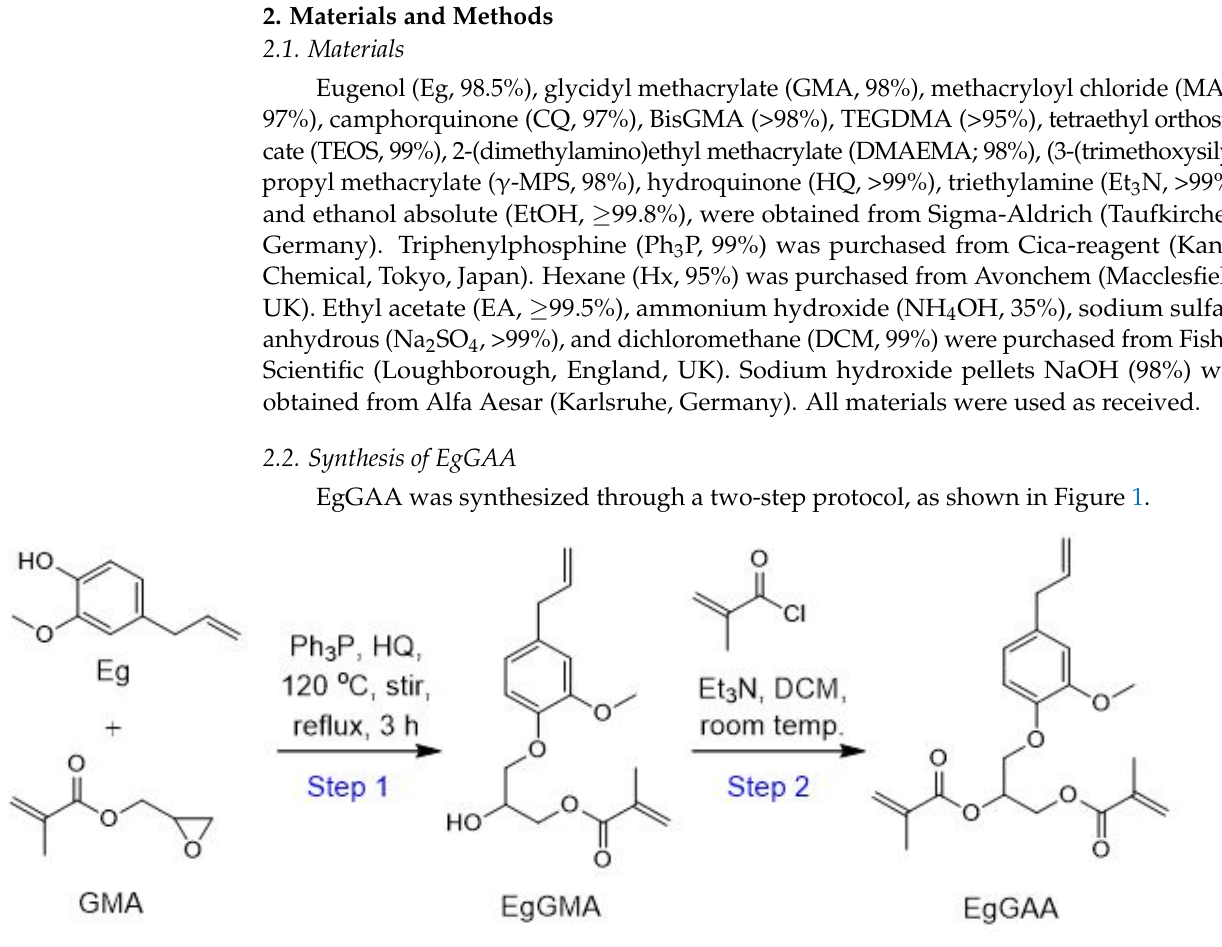
Figure 1. Synthesis of EgGAA